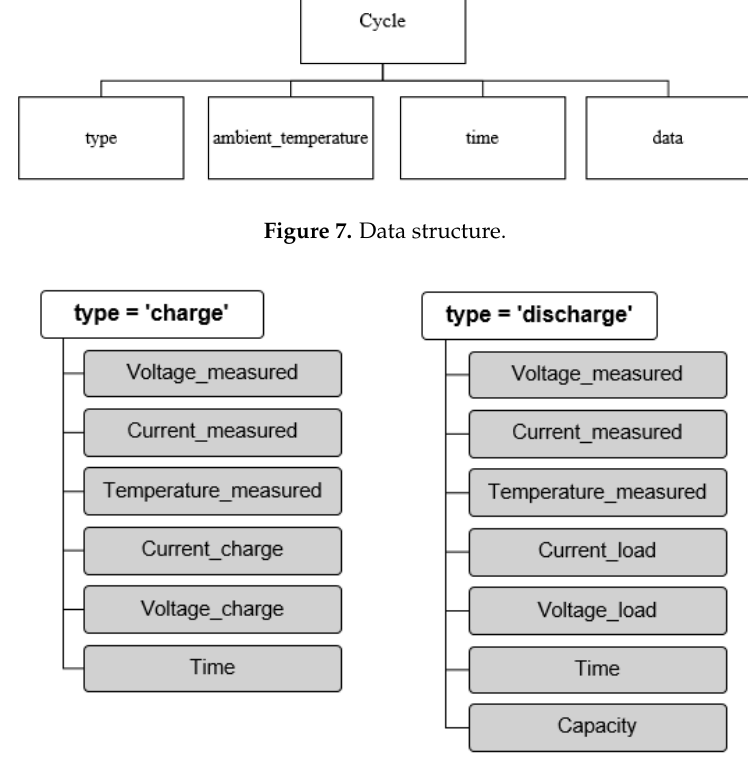
Figure 8. Data fields for charge and discharge cycles.